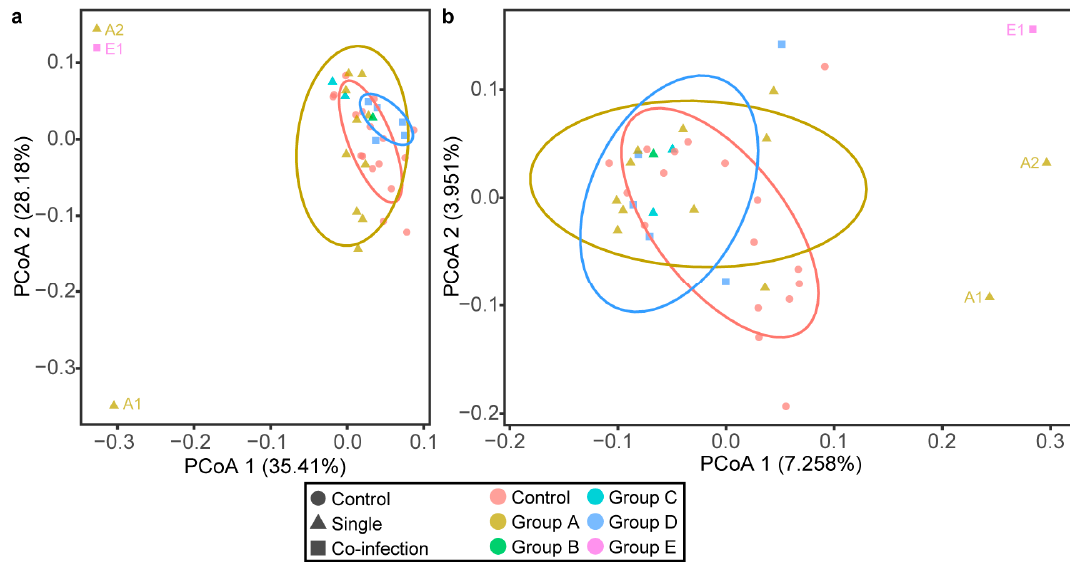
Figure 3. Principal Coordinate Analysis (PCoA) with weighted/unweighted UniFrac distance analysis. PCoA plot of ( a ) the weighted UniFrac distances, ( b ) the unweighted UniFrac distances of fecal microbiota from each Bactrian camel. Control means negative samples of parasites, Single means samples infected with one of Cryptosporidium spp., E. bieneusi. , and G. duodenalis. , Co-infection means samples infected with more than one parasite. As the label shows, exactly infection and indiscriminate positive samples are differentiated by colors and shapes (circle, triangle, and square, respectively).